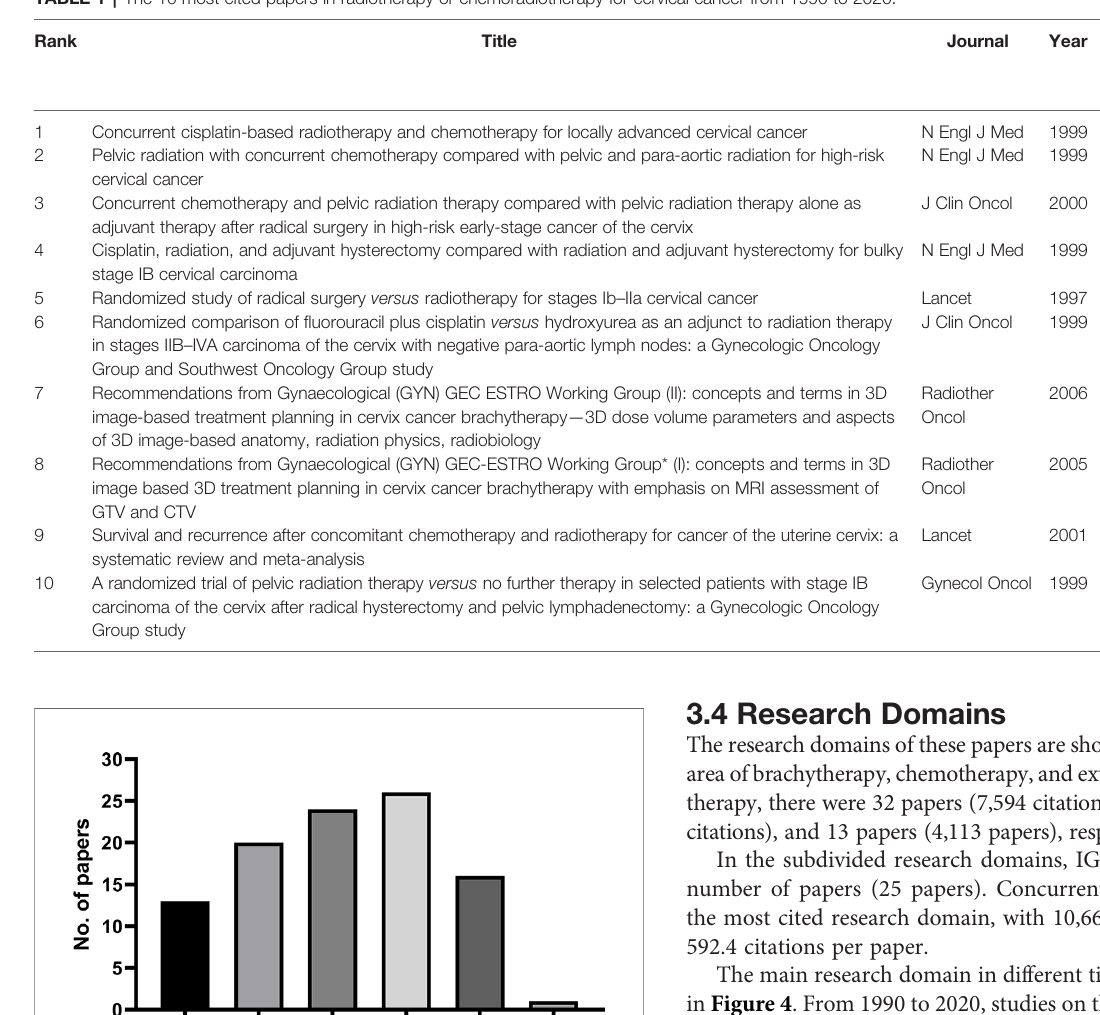
TABLE 1 | The 10 most cited papers in radiotherapy or chemoradiotherapy for cervical cancer from 1990 to 2020.